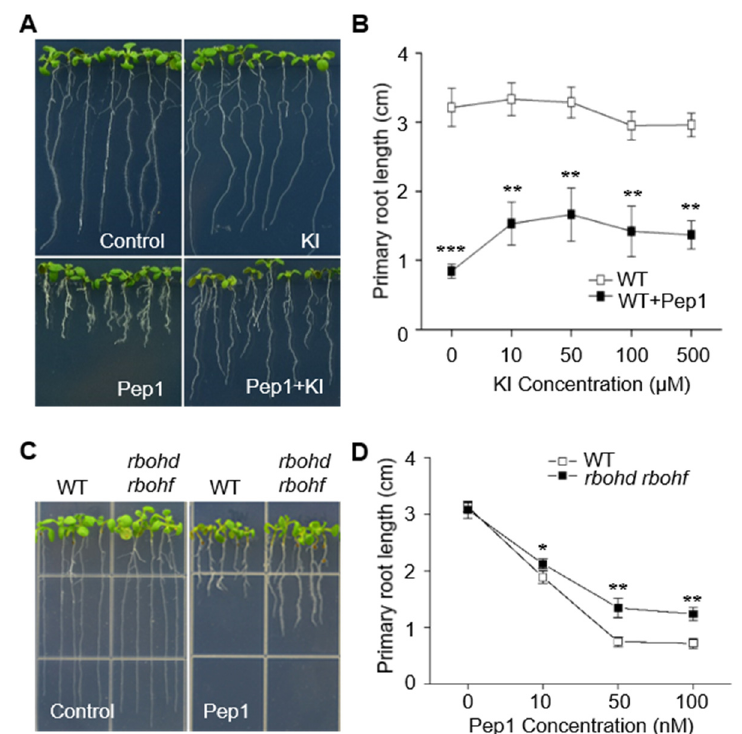
Figure 4. Pep1 intersects with ROS signaling to regulate root growth. ( A ) The growth phenotype of the wild type (WT) roots. The three-day-old seedlings were transplanted on half-strength MS agar medium supplemented with or without (control) 50 µ M KI, 100 nM Pep1, or 100 nM Pep1 + 50 µ M KI for six days. ( B ) The statistical analysis of the primary root length in WT plants. The three-day-old seedlings were transplanted on half-strength MS agar medium, supplemented with or without 100 nM Pep1 in the presence of various concentrations of KI (0–500 µ M) for six days. Data are means ± SD from three independent experiments ( n = 15). ( C ) The growth phenotype of WT and rbohd rbohf root. The three-day-old seedlings were transplanted on half-strength MS agar medium supplemented with or without (control) 100 nM Pep1 for six days. ( D ) The statistical analysis of the ROS production in WT and rbohd rbohf roots. Six-day-old seedlings were incubated in half-strength MS liquid medium with a various concentration of Pep1 (0-100 nM) for six days. Data are means ± SD from three independent experiments ( n = 15). Asterisks in ( B , D ) indicate statistically significant di ff erences compared with the WT in each treatment (Tukey’s test, * p < 0.05, ** p < 0.01, *** p < 0.001).